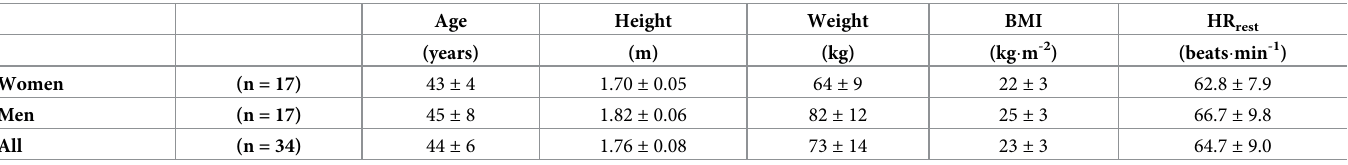
Table 1. Descriptive characteristics of the participants (means ± standard deviations